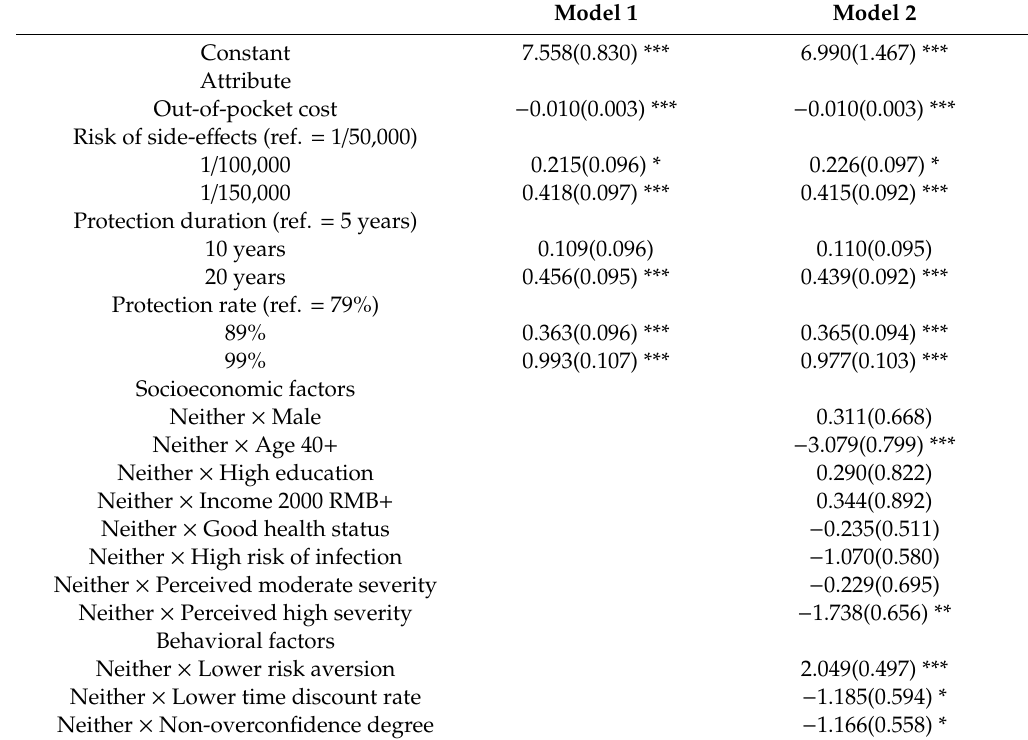
Table 3. Mixed logit model results for a discrete choice experiment addressing adults’ preferences for HBV